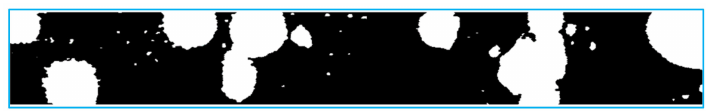
Figure 9. Image of two-phase flow resulting from morphologic operations.